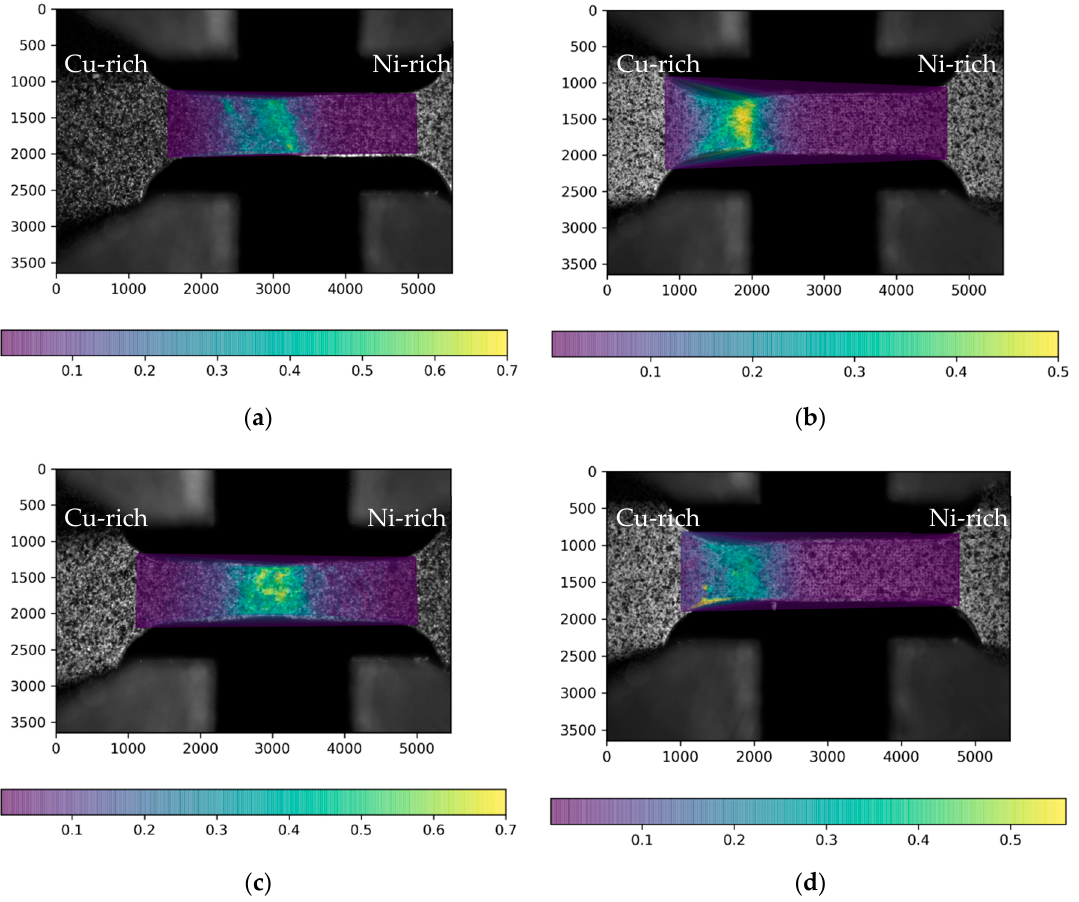
Figure 16. Strain fields from the gage length elongation values calculated from DIC analysis for: ( a ) Set 1 100/0 on 30/70, ( b ) Set 1 30/70 on 100/70, ( c ) Set 3 100/0 on 30/70, and ( d ) Set 3 30/70 on 100/0 deposits.